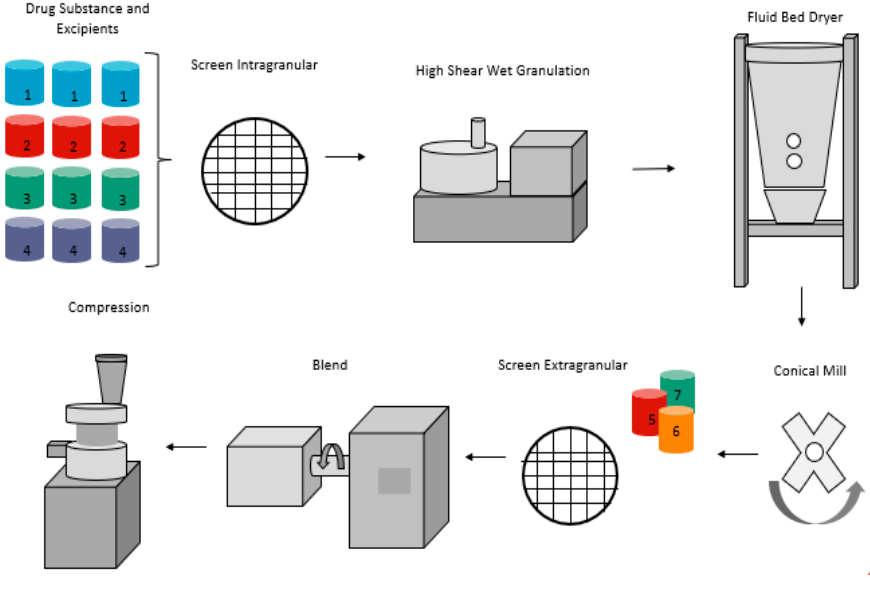
Figure 4. High shear wet granulation operation.